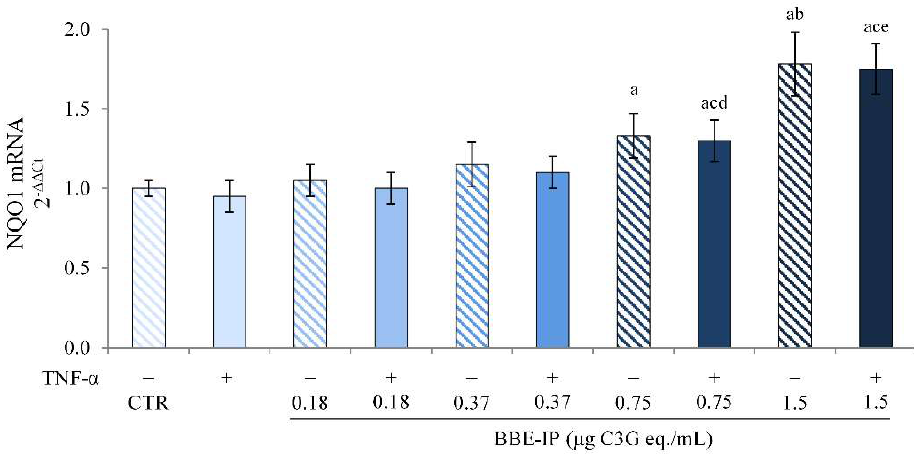
Figure 6. Nuclear Nrf2. Differentiated Caco-2 cells were pretreated or not for 24 h with different concentrations of the BBE-IP (0.18, 0.37, 0.75, 1.5 µ g C3G eq./mL). Cells were subsequently exposed to 50 ng/mL TNF- α for 6 h. Cells treated with the vehicles alone were used as controls (CTR). Results are reported as fold change against CTR and expressed as mean ± SD of three independent experiments. Nrf2 values were normalized to the corresponding Lamin b value. a p < 0.05 vs. CTR; b p < 0.05 vs. TNF- α ; c p < 0.05 vs. BBE-IP 0.18 unexposed to TNF- α ; d p < 0.05 vs. BBE-IP 0.18 exposed to TNF- α ; e p < 0.05 BBE-IP 0.37 unexposed to TNF- α ; i p < 0.05 BBE-IP 1.5 unexposed to TNF- α .